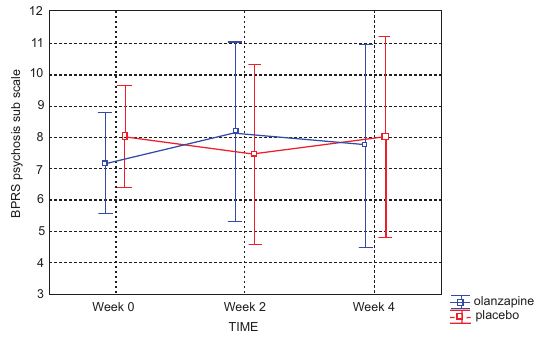
Figure 2. Brief Psychiatric Rating Scale (BPRS) scores across four week study revealed no significant difference between placebo and olanzapine groups among study completers. Current effect: F(2, 24)=0.64064, p=0.53573. Effective hypothesis decomposition. Vertical bars denote 0.95 confidence intervals. Olanzipine-blue; placebo-red.